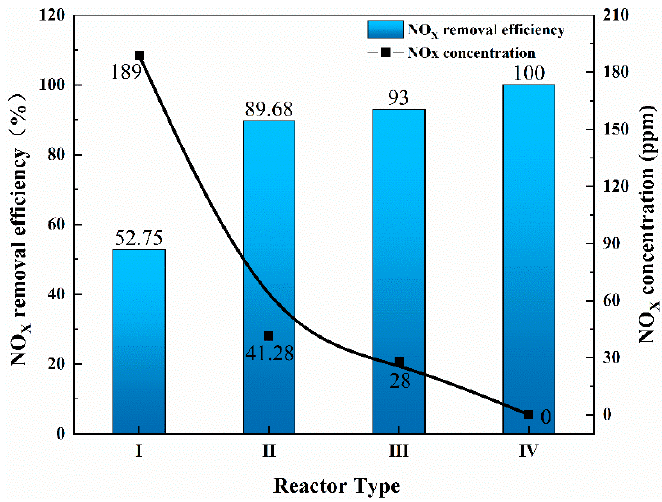
Figure 9. Effects of different types of reactors on NO X removal efficiency.